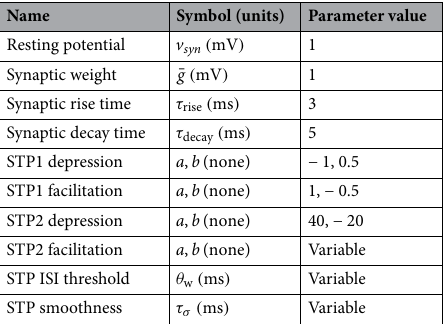
Table 3. Model parameters for the decoding